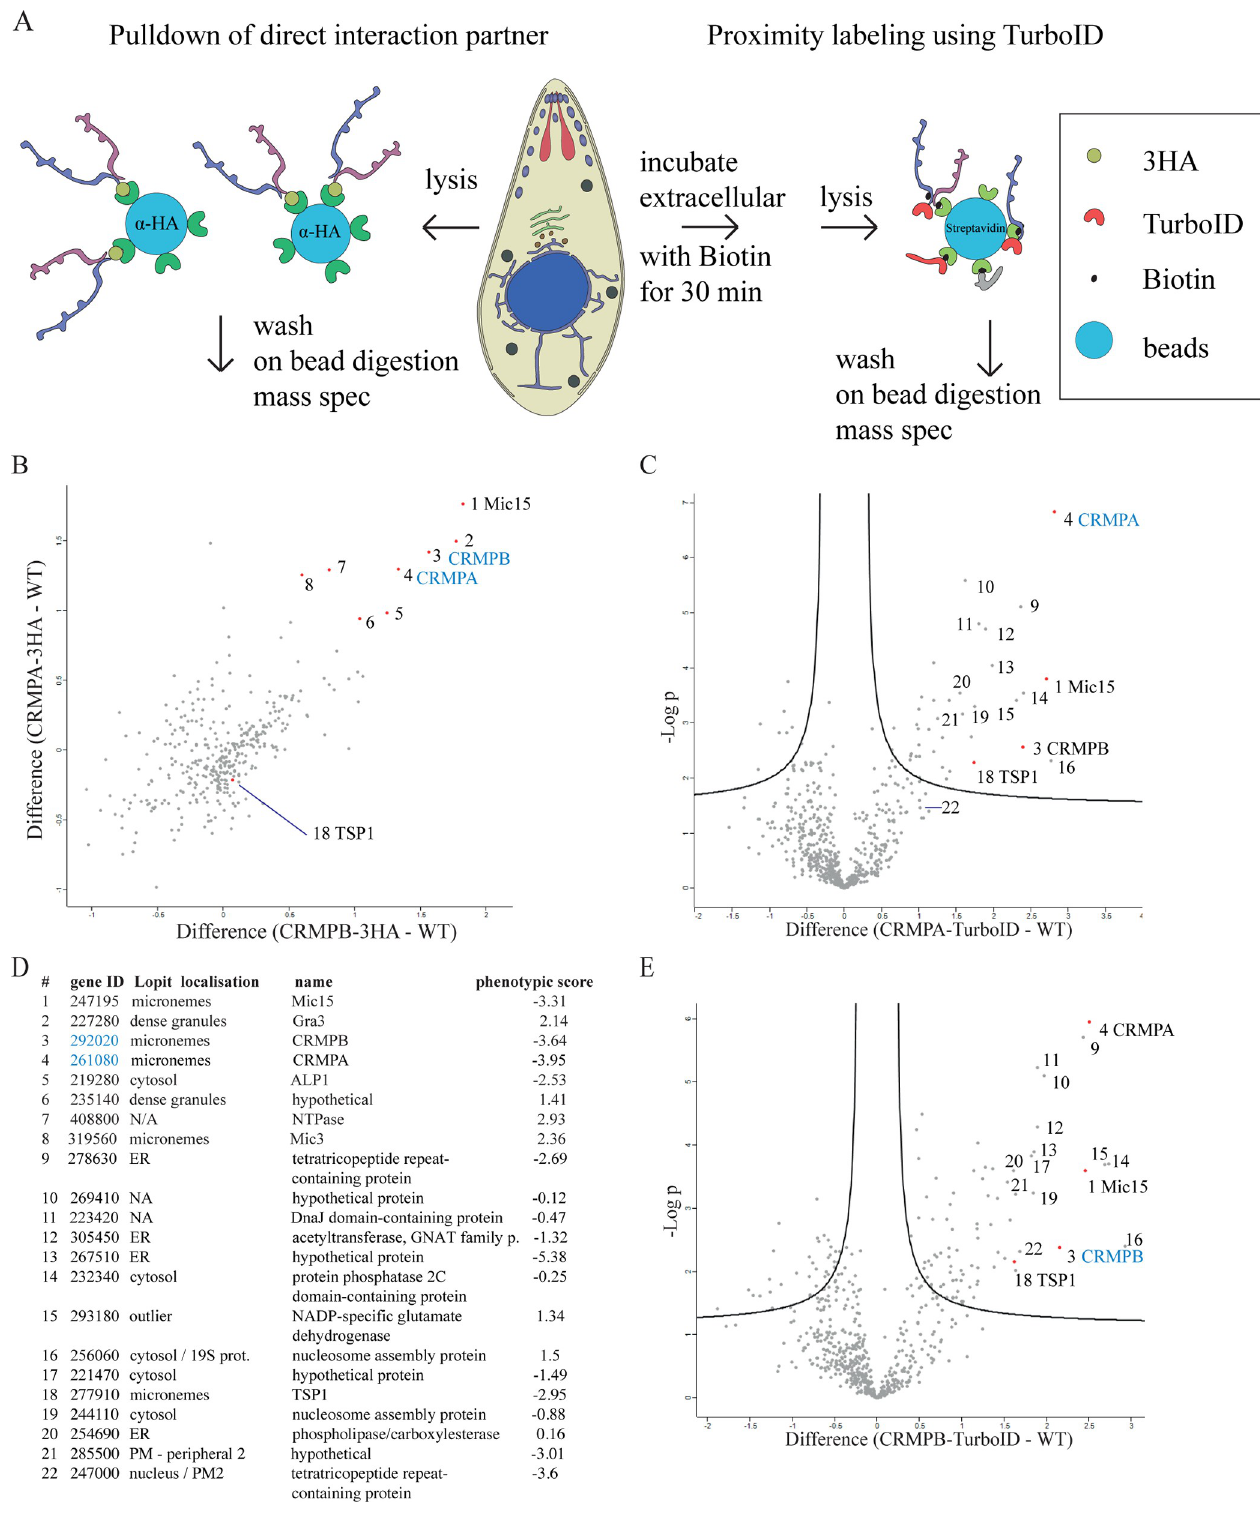
Fig 4. Identification of interaction partners. ( A ) Experimental outline of mass spectrometry–based protein identification. Parasites with C-terminally tagged 3HA were used for direct pulldown experiments (depicted on the left, results shown in ( B) ). In a separate experiment, C-terminally tagged CRMPA or B with TurboID was used in an attempt to identify more transient interaction partners of the CRMPs post-secretion. Here, pulldown with streptavidin-coupled beads